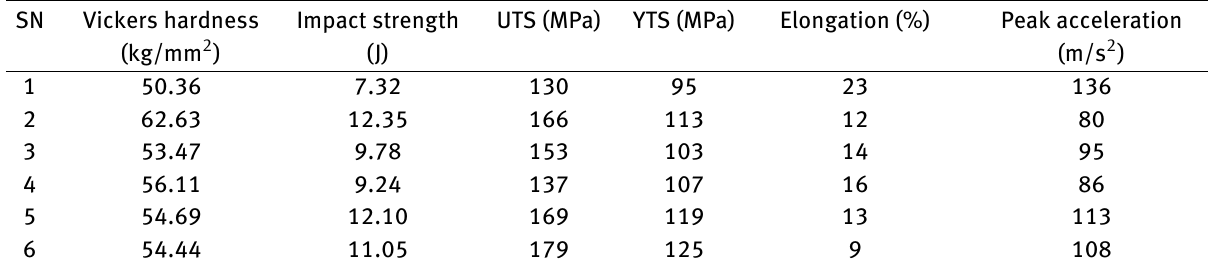
Table 11: Observation of mechanical properties and peak acceleration of Al 6063 and their constituents. SN Vickers hardness (kg/mm 2